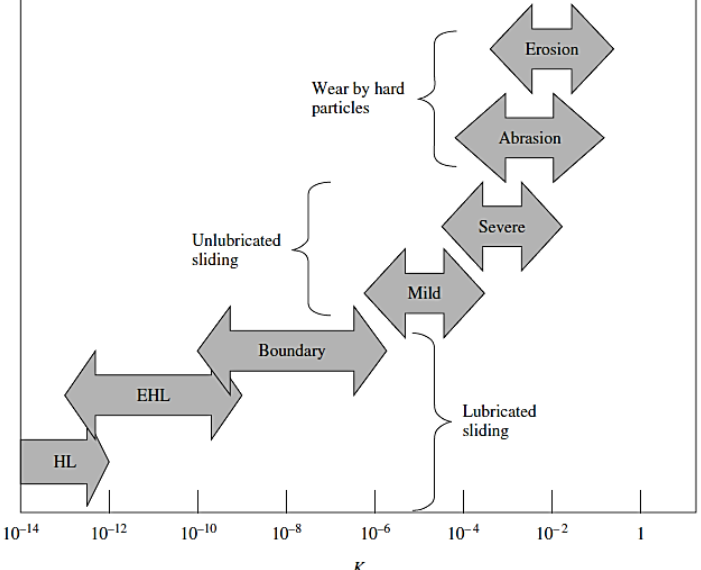
Figure 12. Schematic representation of the range of wear coefficient exhibited under different of wear (HL: hydrodynamic lubrication; EHL: elastohydrodynamic lubrication) (Reprinted with conditions of wear (HL: hydrodynamic lubrication; EHL: elastohydrodynamic lubrication) permission from John Wiley & Sons, Copyrights 2005) (Reprinted with permission from John Wiley & Sons, Copyrights 20 05 ) [86].